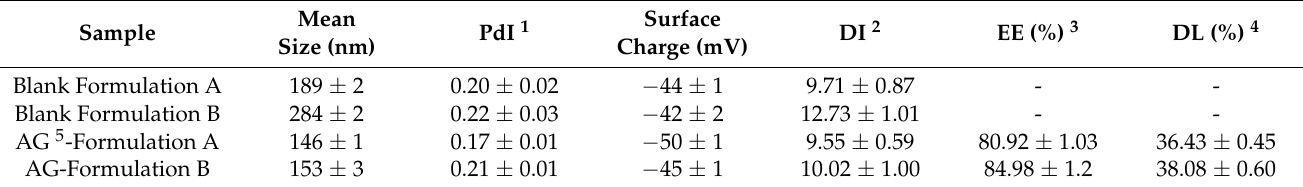
Table 2. Physico-chemical features of blank and ammonium glycyrrhizinate-loaded unsaturated fatty acid vesicles